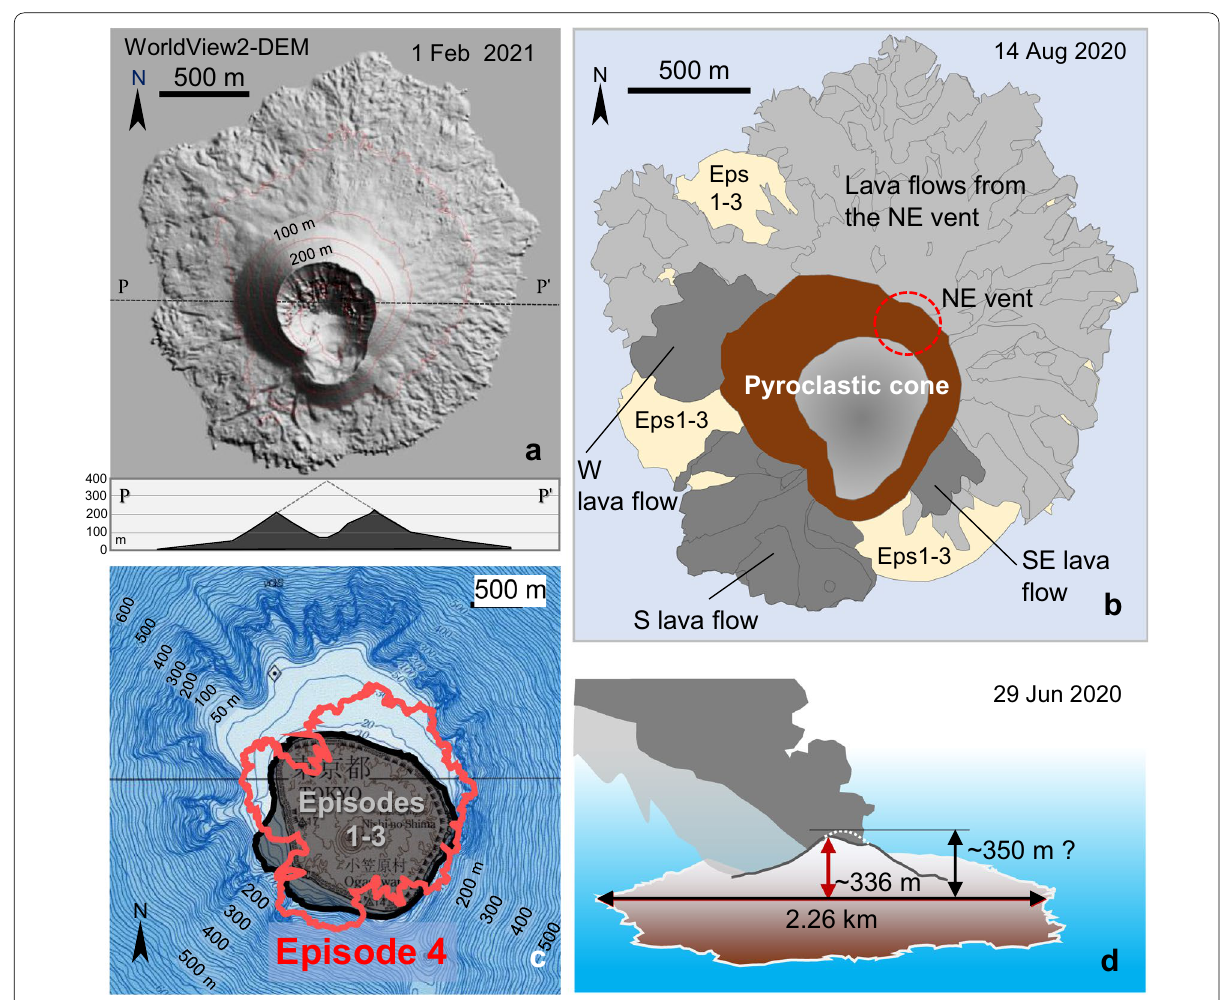
Fig. 2 Topographic characteristics of the edifice formed in the Episode 4 activity of Nishinoshima. a Digital Elevation Model (DEM) of Nishinoshima after the Episode 4 activity produced from a stereo pair of WorldView-2 images taken on 1 February 2021 (the same image as Fig. 1e). The lower illustration shows the cross section of the island. b Sketch of Nishinoshima in the final stage of the Episode 4 activity. c Enlargement of Nishinoshima Island between Episodes 3 and 4 (the base map is a bathymetric chart by the Japan Coast Guard; Japan Coast Guard, 2017). d Estimation of the maximum height of Nishinoshima during the Episode 4 activity, based on the aerial photograph taken on 19 June 2020